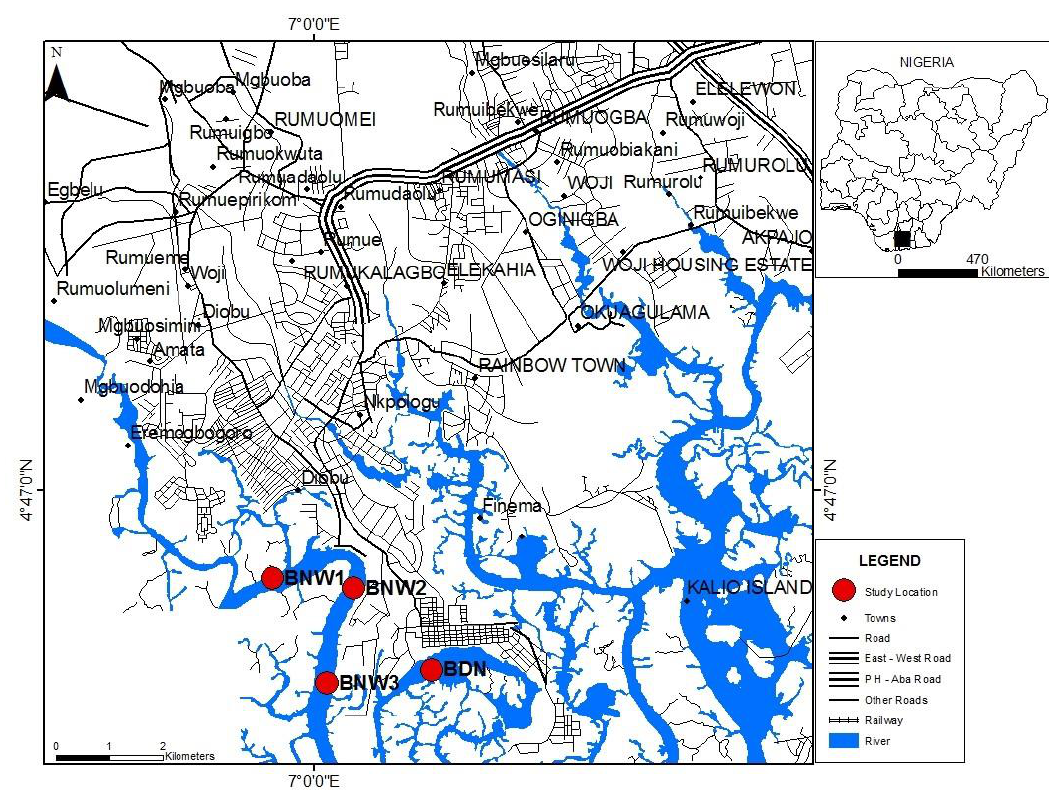
Figure 1. Map of the study area (insets: Nigeria showing Niger Delta; Niger Delta showing Rivers; Rivers State showing Port Harcourt and the Bonny estuary with sampling